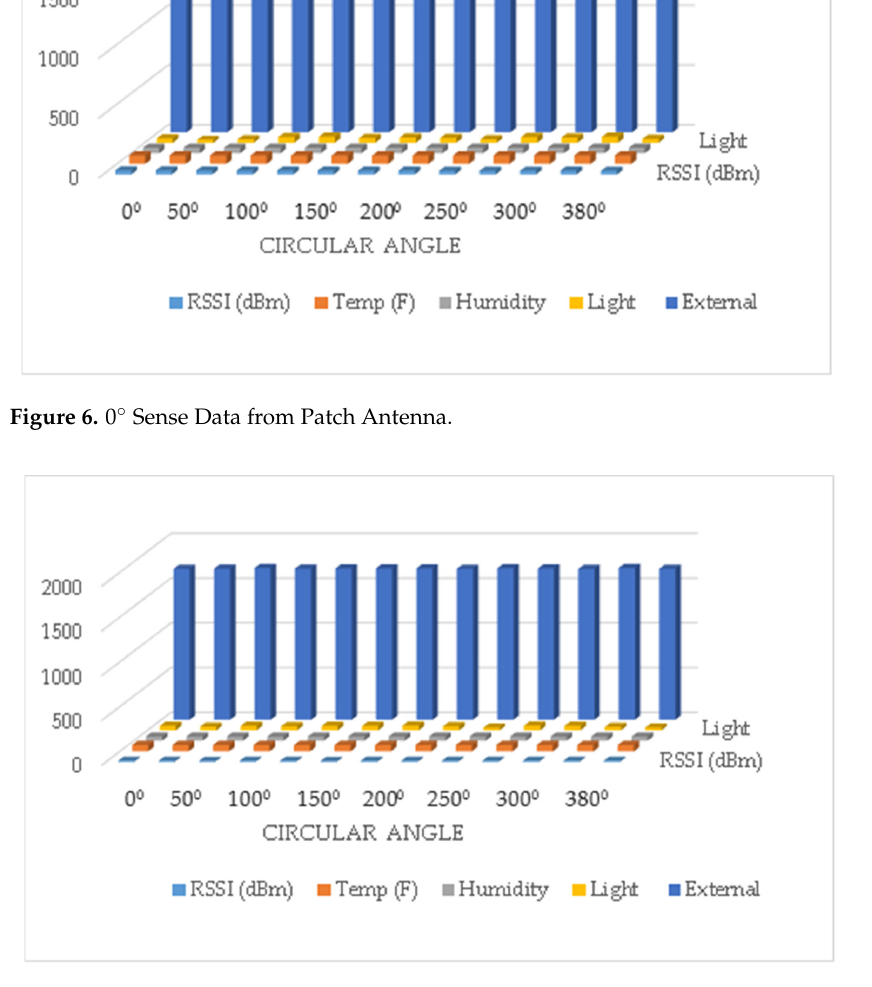
Figure 7. 50° Sense Data from Patch Antenna.